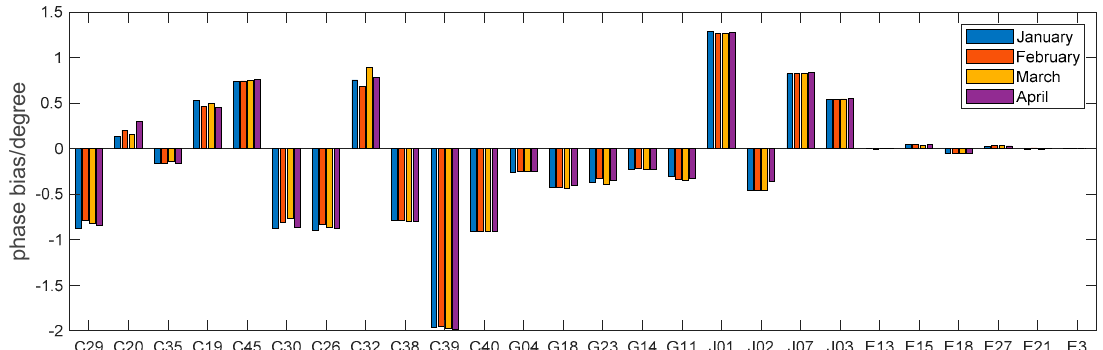
Figure 14. Carrier phase bias between data and pilot of MBOC signal in 2020.